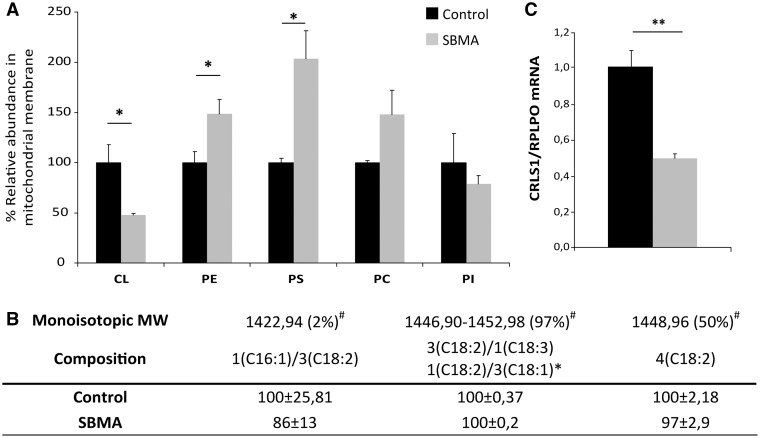
Reduced cardiolipin levels and biosynthesis in the muscle of SBMA patients. (A) Mass spectrometry lipidomic analysis of mitochondrial membranes isolated from SBMA patients and control subjects. Cardiolipin (CL), phosphatidylethanolamine (PE), phosphatidylserine (PS), phosphatidylcholine (PC) and phosphatidylinositol (PI) amounts were normalized to CS activity. Graph, mean ± SEM, n = 4 SBMA patients and 4 control subjects. (B) Composition of CL molecular species in control and SBMA muscle samples. The values are expressed as mean ± SEM of two independent experiments. #Percentage of the molecular species/total CL. *Range of the major combinations among the shown acyl moieties. (C) Real-time PCR analysis of cardiolipin synthase (CRLS1) normalized to RPLPO in the muscle of SBMA patients and control subjects. Graph, mean ± SEM, n = 5 SBMA patients and 6 control subjects. Significance by Student’s t test: *P < 0.05, **P < 0.01.